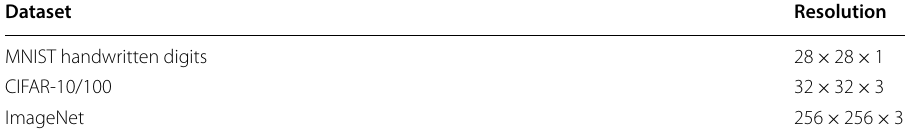
Table 10 Comparison of resolution across three very popular open-source image datasets